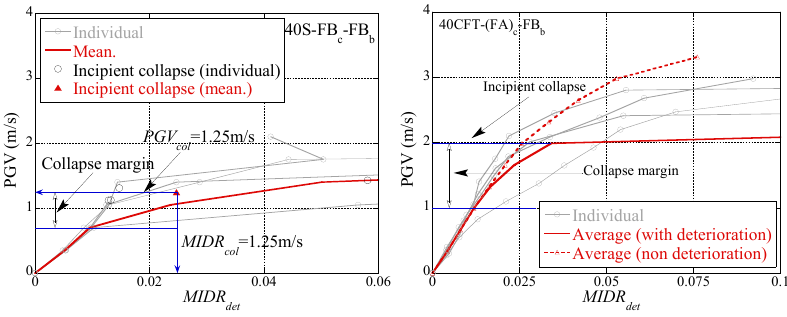
Figure 15. Average collapse margin of high ‐ rise SMRF and CFST ‐ MRF models.